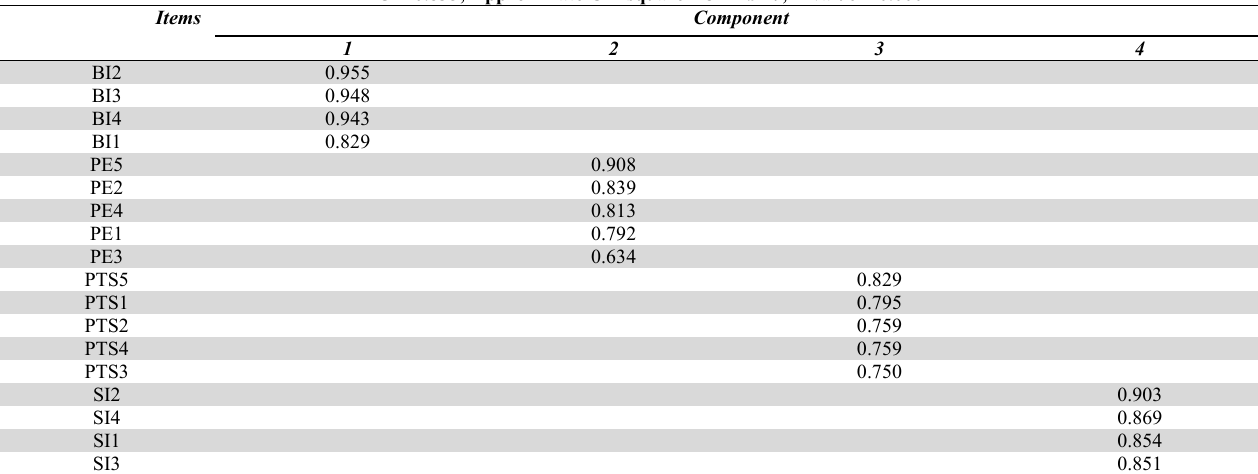
EFA analysis result after Varimax rotation